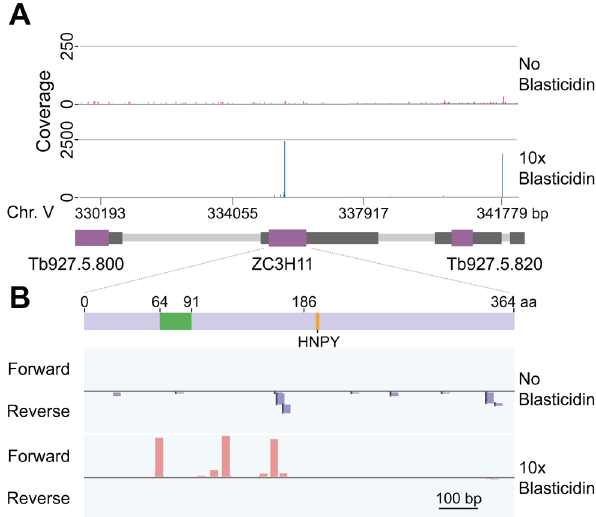
Figure 3. Results for ZC3H11. ( A ) Sequence reads that were linked to the lambda-N peptide were extracted, mapped onto the trypano- some genome and visualised using the Integrative Genomics Viewer (IGV) tool. The Figure shows the sequence coverage plots for a , 12 kbp region of chromosome 5. Open reading frames are in purple and mRNA untranslated regions in dark grey. Reads were derived from tetracycline- induced cells grown without blasticidin (upper panel), or with the 10x blasticidin concentration (bottom panel). For better visualization, the plotted Y scales display different range values. In the 10x blasticidin plot, note the cluster over ZC3H11; the isolated ‘‘pile’’ downstream of Tb927.5.820 would be removed later in the filtering process. ( B ) These are the same results as in (A), but in close-up focusing on the ZC3H11 (Tb927.5.810) open reading frame. Each ‘‘stack’’ represents a unique target fragment, mapped to forward (plus) and reverse (minus) strands, for induced cells grown without (upper panel) and with (bottom panel) blasticidin pressure. Light blue boxes indicate the ZC3H11 coding sequence (transcribed left to right) while zinc finger domain and HNPY motif (residues 186–189) are indicated in green and orange respective- ly. The minimum region that was required for activity in tethering assays was the C-terminal part, starting at amino acid